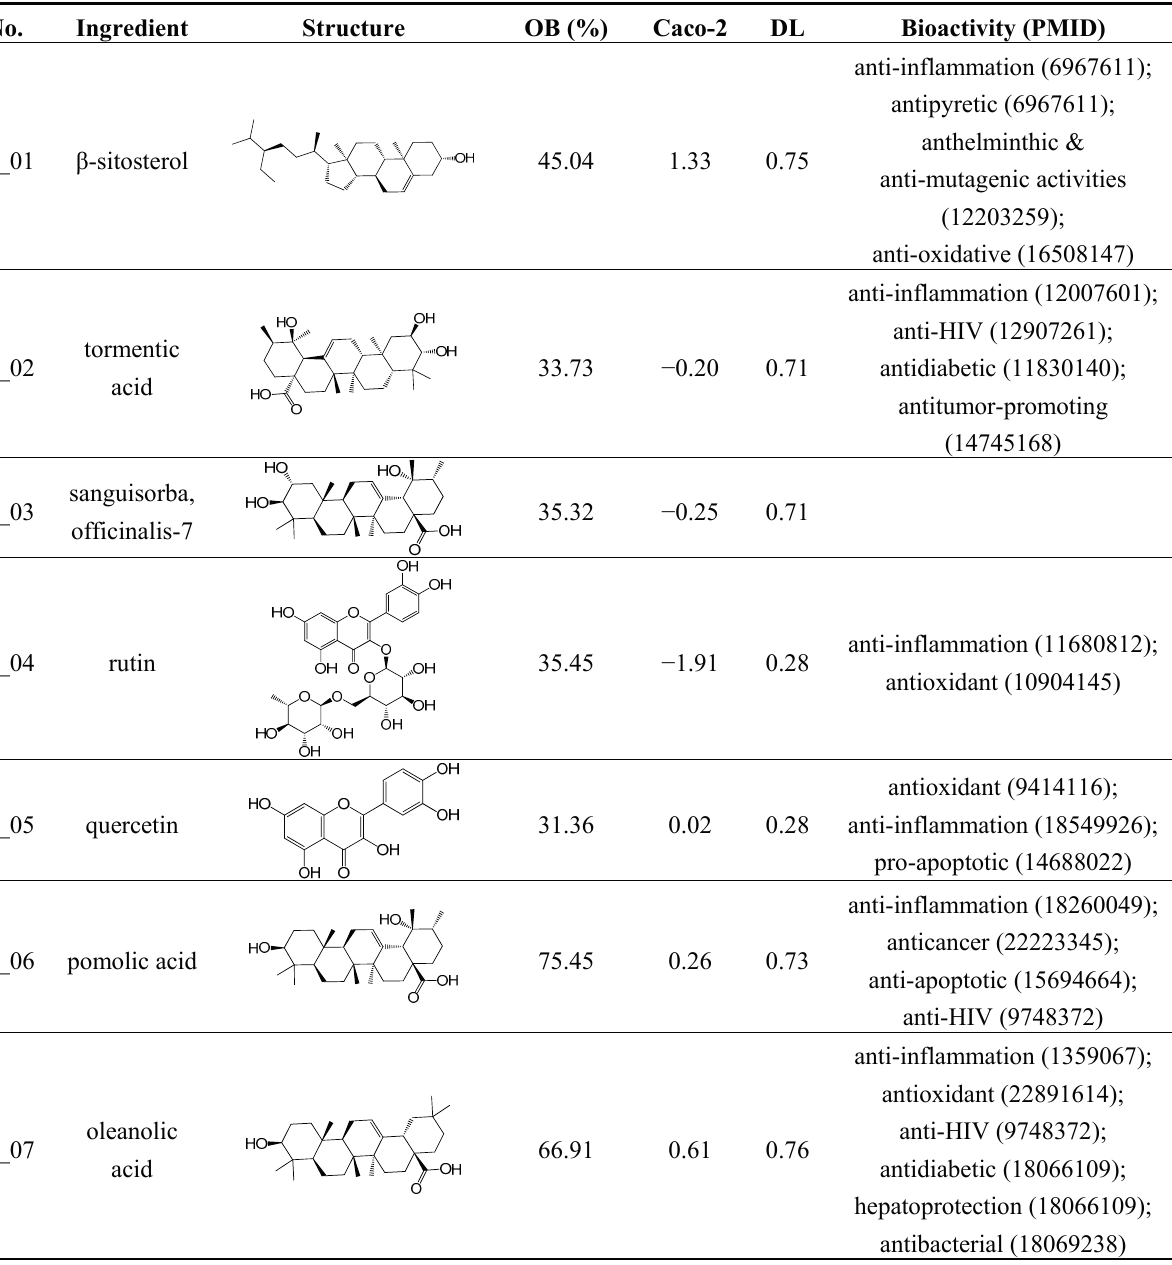
Table 1. The pharmacokinetic and biological information of potential active ingredients of Folium